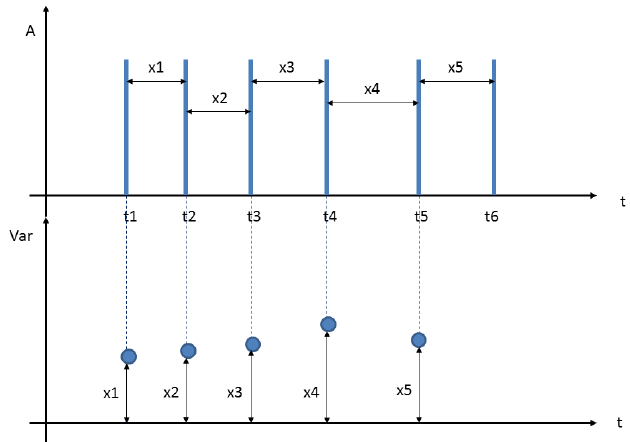
Figure 15. Variability method.